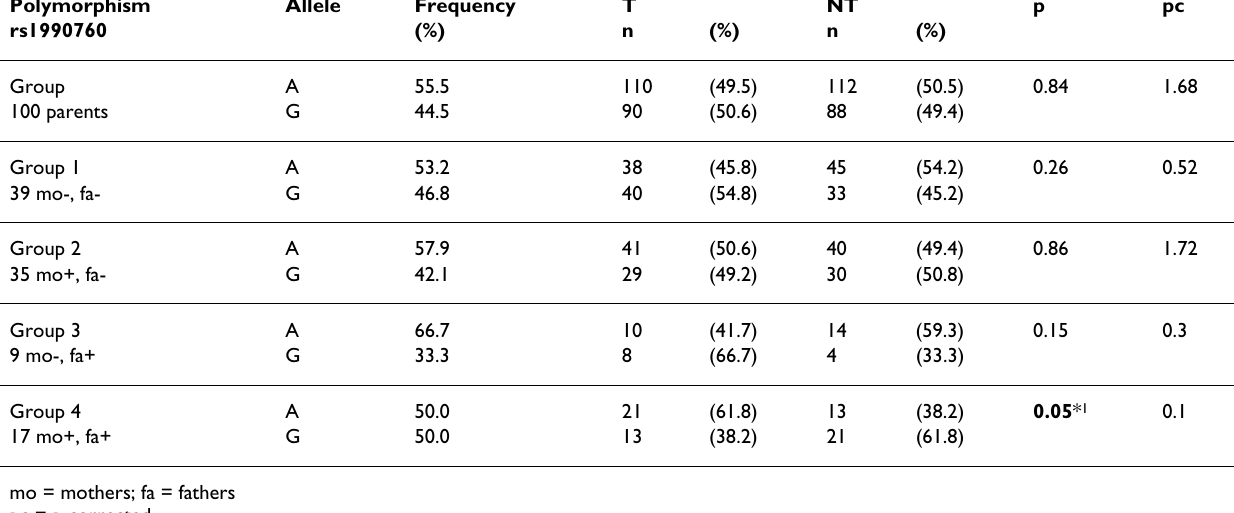
Table 2: Transmission (T) and non transmission (NT) of IFIH1 rs1990760 polymorphism in 100 Hashimoto's thyroiditis families (Italian) according to the presence of thyroid antibodies (TPO and TG)